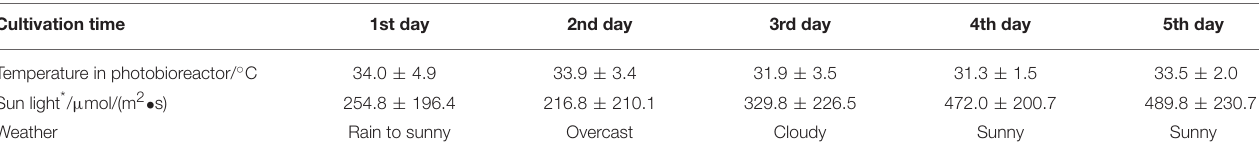
TABLE 2 | Weather conditions of microalgae cultivation. Cultivation